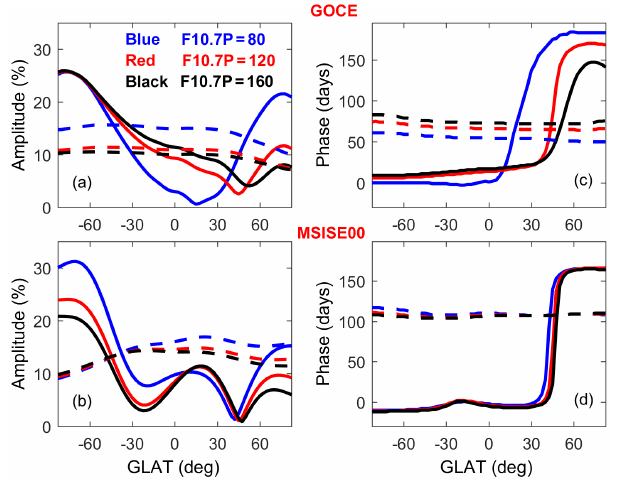
Figure 6. (a) Annual asymmetry index R at dawn LST at each geo- graphic latitude for different solar activities at 1AU (solid line) and Sun–Earth distance (dashed line), and (b) the contributions of the Sun–Earth distance are also